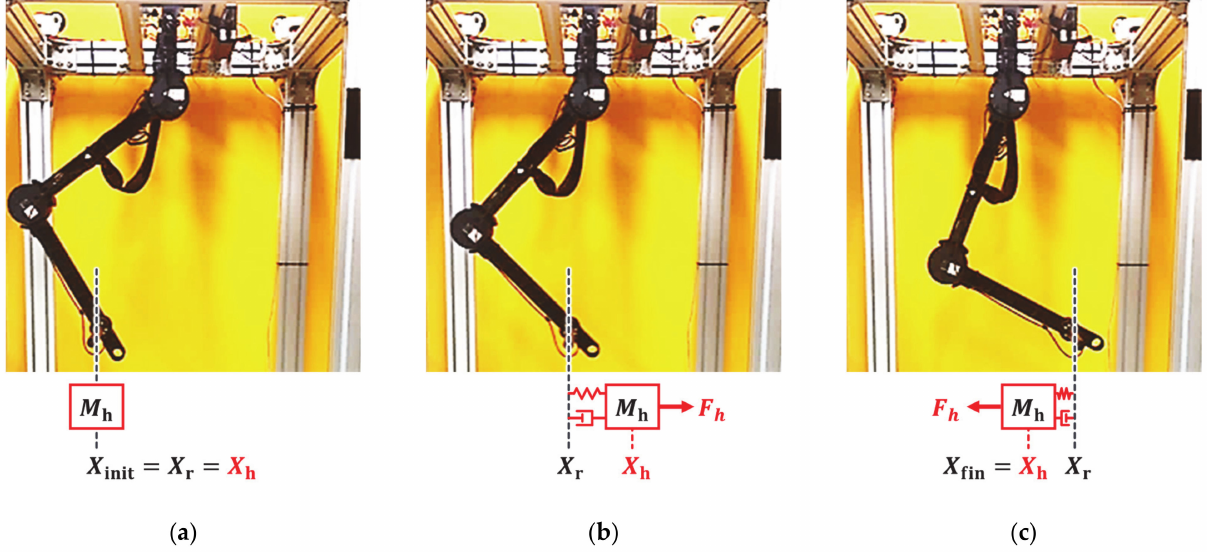
Figure 8. Experimental setup for sudden change of operator’s intention. ( a ) Starting position. ( b ) Motion with constant speed. ( c ) Stop with sudden